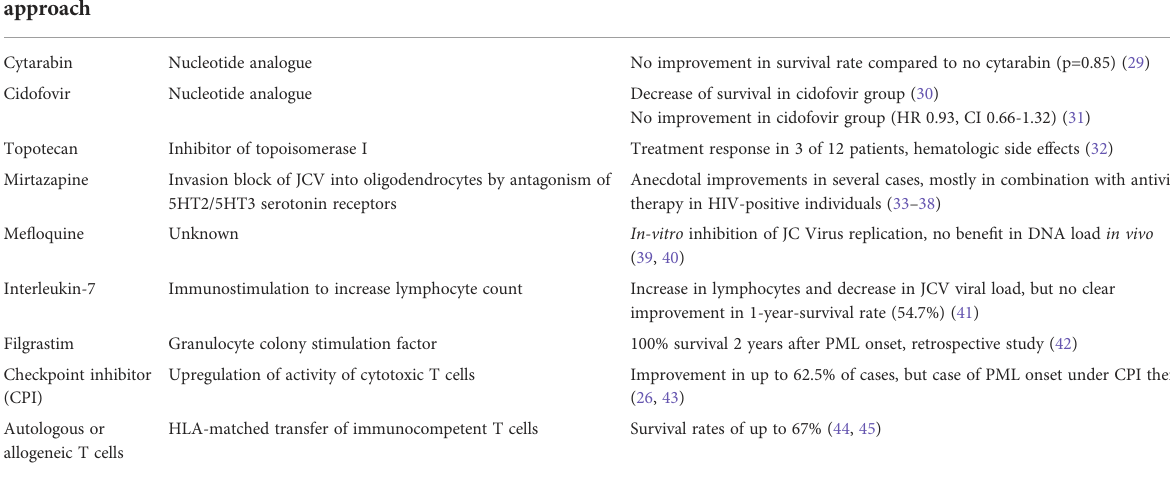
TABLE 1 Overview of currently discussed treatment options in